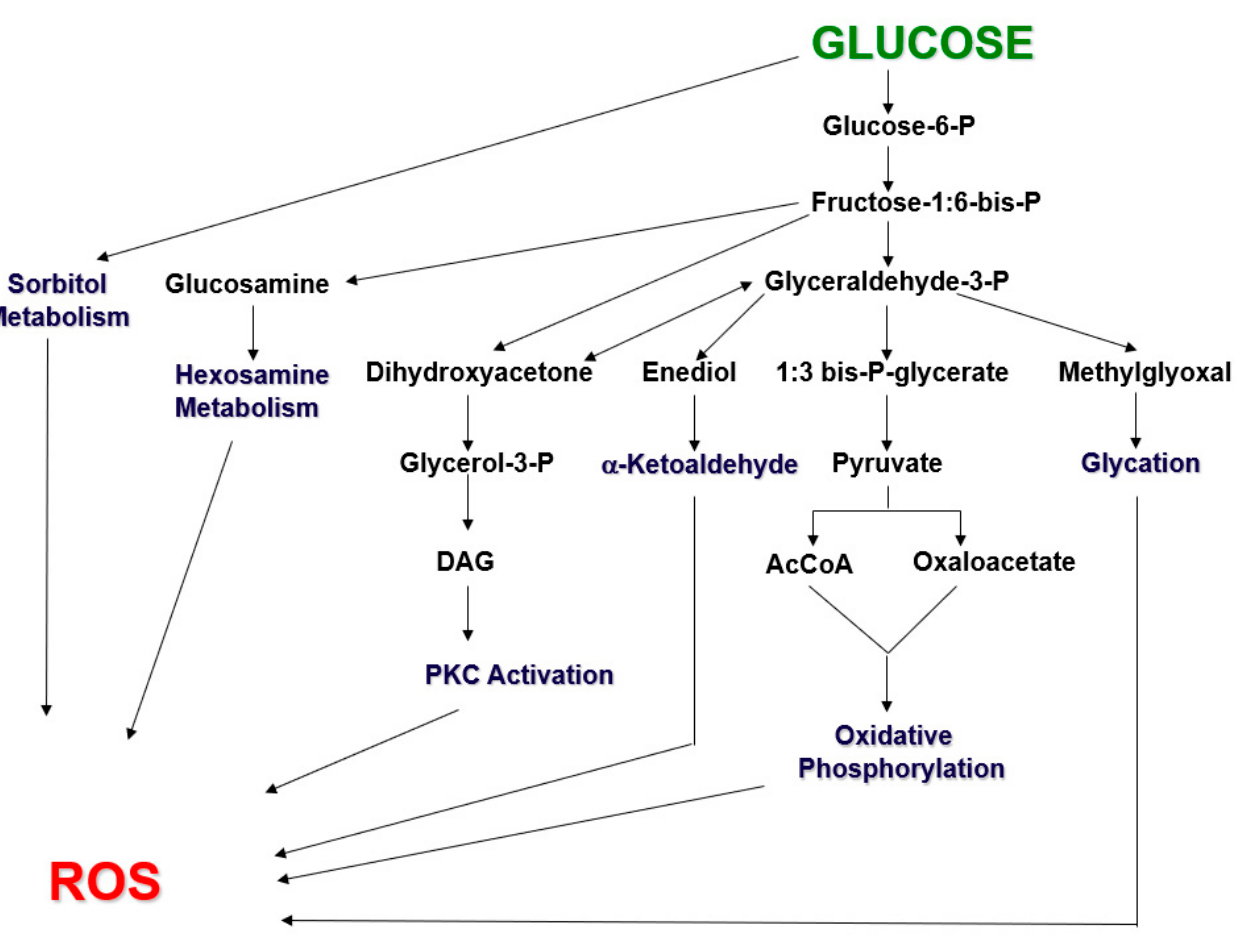
Figure 1. Metabolic pathways along which glucose metabolism can form reactive oxygen species (ROS). Under physiologic conditions, glucose primarily undergoes glycolysis and oxidative phos- phorylation. Under hyperglycemic conditions, excessive glucose levels can swamp the glycolytic process and glyceraldehyde catabolism, so that metabolites are shunted to other pathways, which then generate increasing levels of ROS. Modified from reference [1].